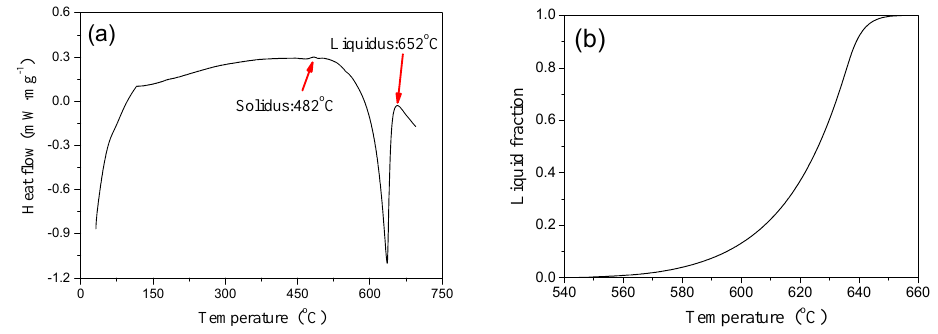
Figure 1. DSC curve ( a ) and the variation of liquid fraction versus heating temperature ( b ) of AA7075 alloy.